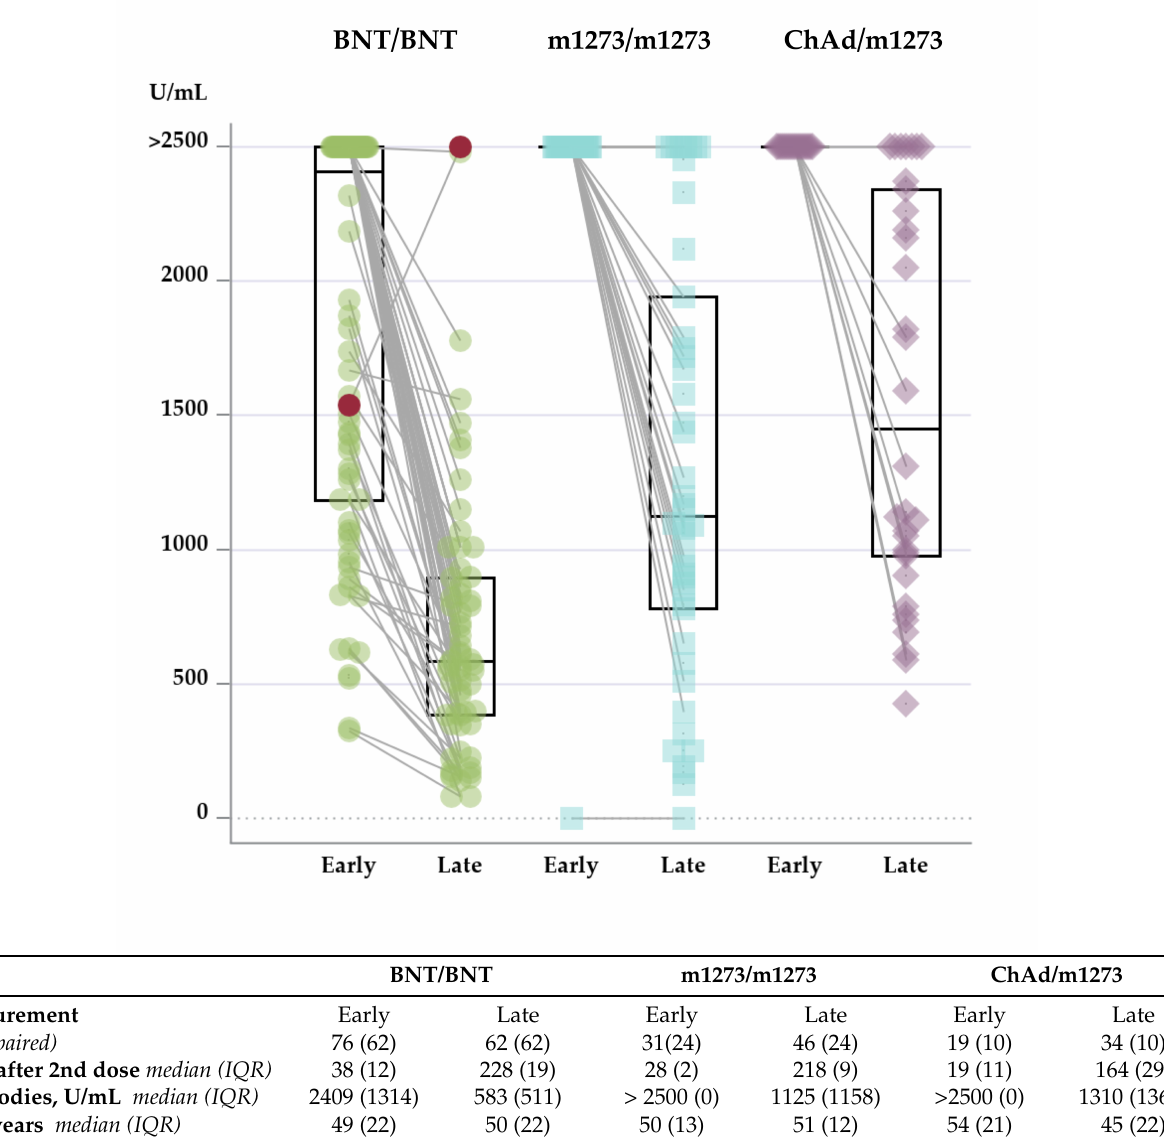
Figure 2. Concentration of antibodies against SARS-CoV-2 spike (S) protein in plasma at late and early measurements according to vaccine regimen. Results are presented as box plots, where the ends of the boxes define the 25th and 75th percentiles and with a line at the median. Individual values for each vaccine group appear as green circles (BNT/BNT, the BNT162b2 mRNA vaccine from Pfizer/BioNTech), blue squares (m1273/m1273, the mRNA-1273 vaccine from Moderna), and purple diamonds (ChAd/m1273, the heterologous vaccine regimen combining ChAdOx1 vaccine from AstraZeneca with m1273 from Moderna). Individuals with paired measurements (both early and late antibody measurements in the same person) are marked with a line combining the two measurements. N is the number of individuals in each vaccine group and N-paired is the number of individuals with paired measurements. The red circle indicates one participant with a PCR-confirmed infection with SARS-CoV-2 between early and late tests. Interquartile range (IQR) indicates the difference between the 75th and 25th